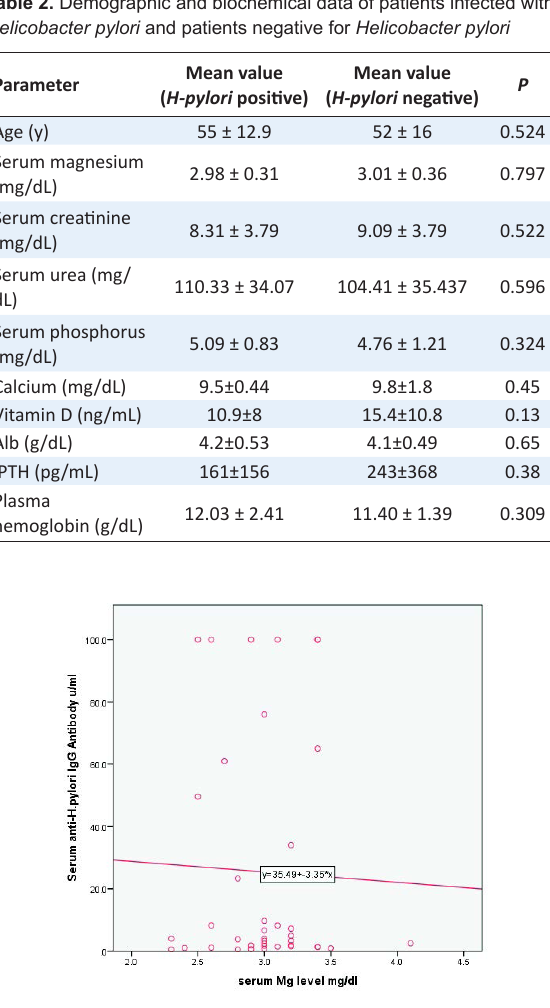
Figure 1. No significant correlation was found between serum H. pylori IgG and serum magnesium